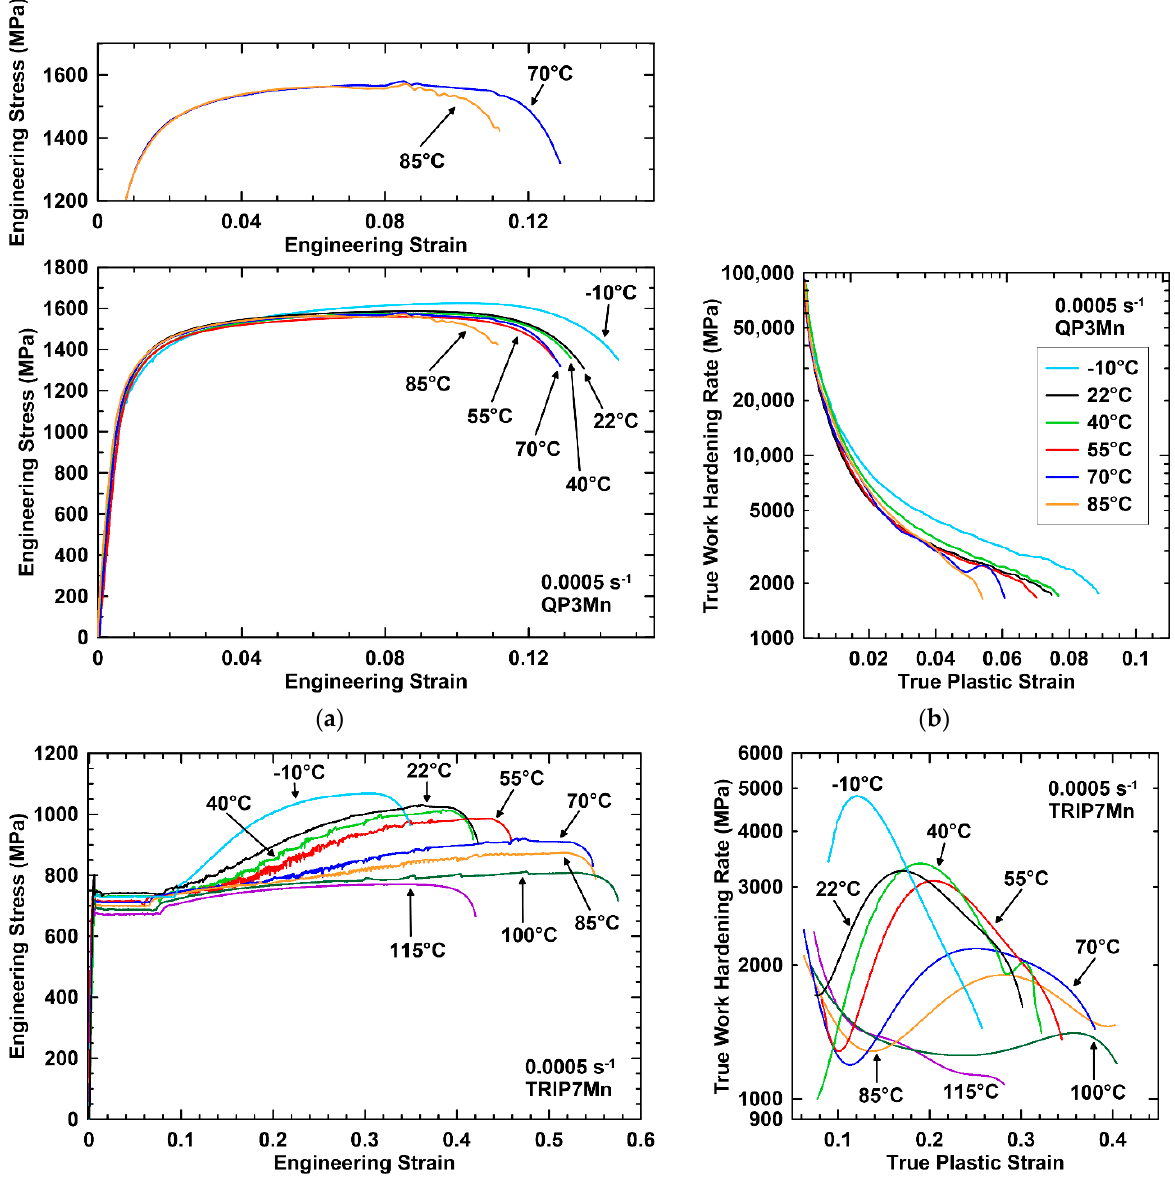
Figure 3. Representative engineering stress–strain curves from tests at 0.0005 s − 1 and various temperatures for ( a ) QP3Mn and ( c ) TRIP7Mn. Serrated flow behavior during necking is shown by the zoomed-in stress–strain plot for QP3Mn. Work hardening rate (d σ /d ε ) as a function of strain from tests at 0.0005 s − 1 and various temperatures for ( b ) QP3Mn and ( d ) TRIP7Mn. Work hardening rate was calculated from a smoothed true stress–strain curve obtained by a polynomial fit to the plastic deformation region between yield point elongation (YPE)/yielding and necking.